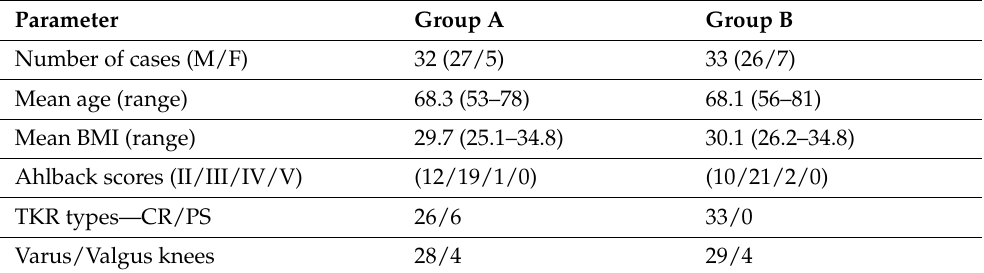
Table 1. Cohort characteristics. BMI–body mass index.